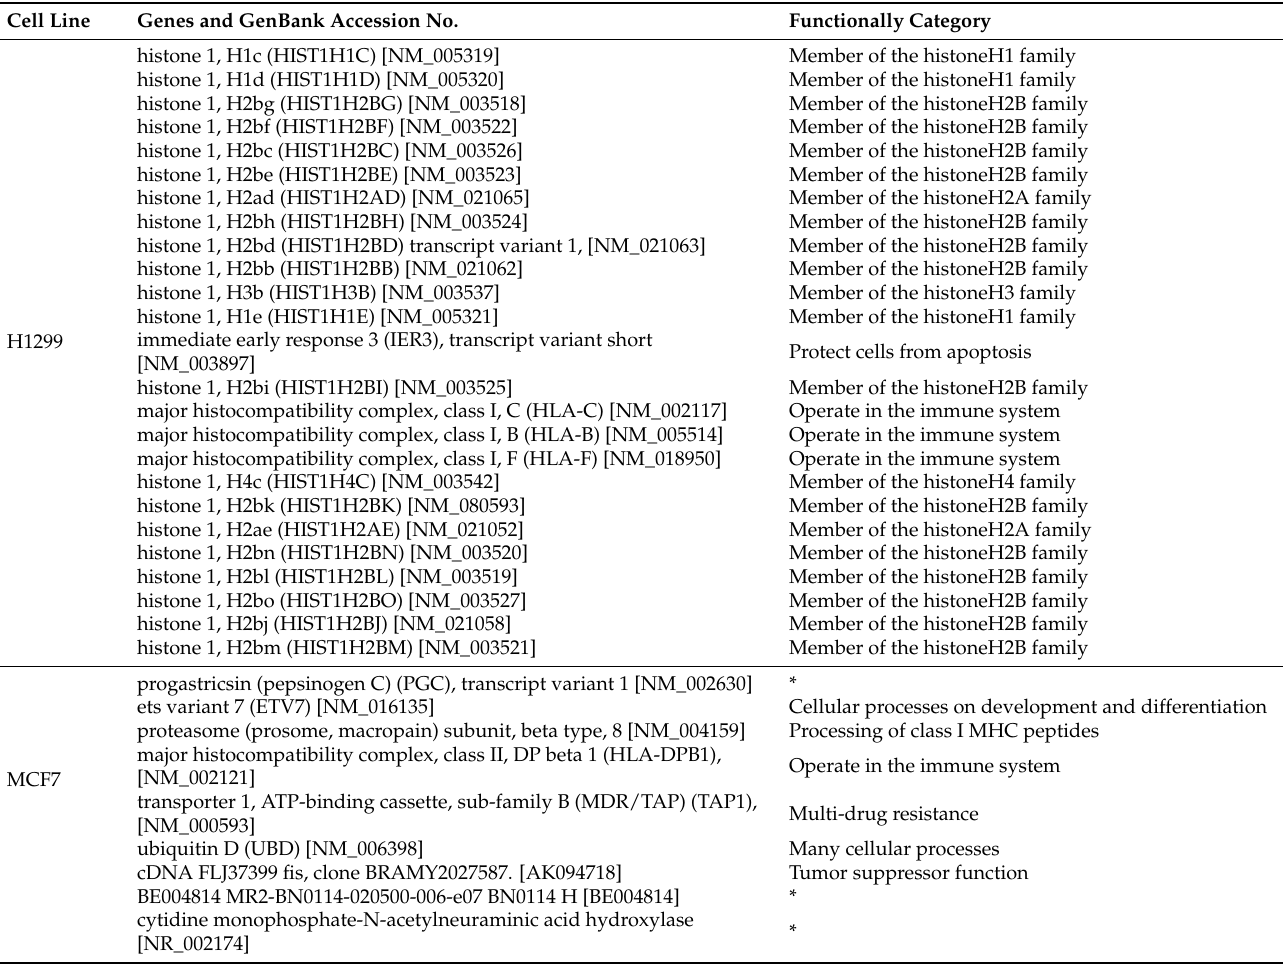
Table 3. Functional categories of up-regulated genes in chromosome 6p21-22. Cell Line Genes and GenBank Accession